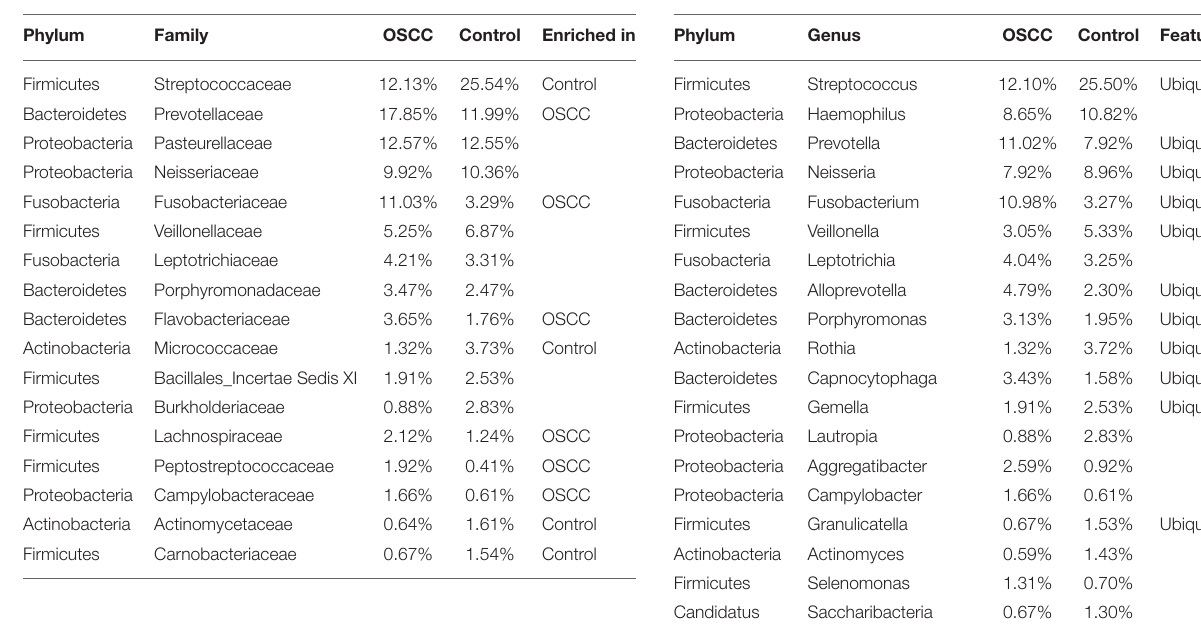
TABLE 3 | Dominant genera and significant differences between the OSCC and Control groups computed by